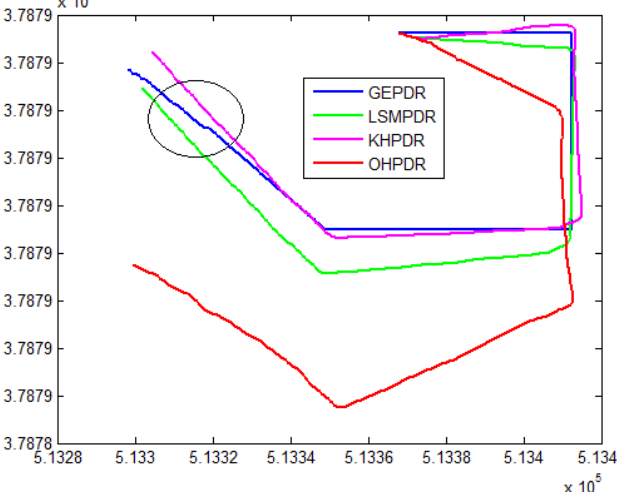
Figure 11. Analysis on positioning trajectory (B–C) for four methods